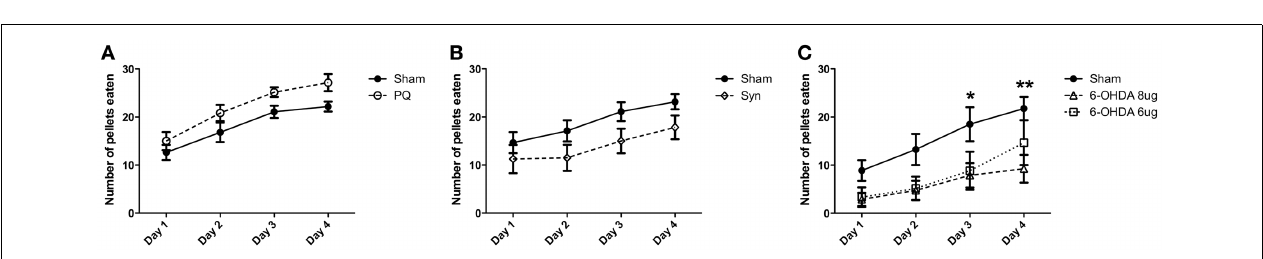
FIGURE 3 | Effects of PQ delivery (A), α -syn overexpression (B) or 6-OHDA injection (C) on paw reaching performance. Performance of rats in the paw reaching test is expressed as mean ± s.e.m. number of eaten pellets. ∗ p < 0 . 05 and ∗∗ p < 0 .